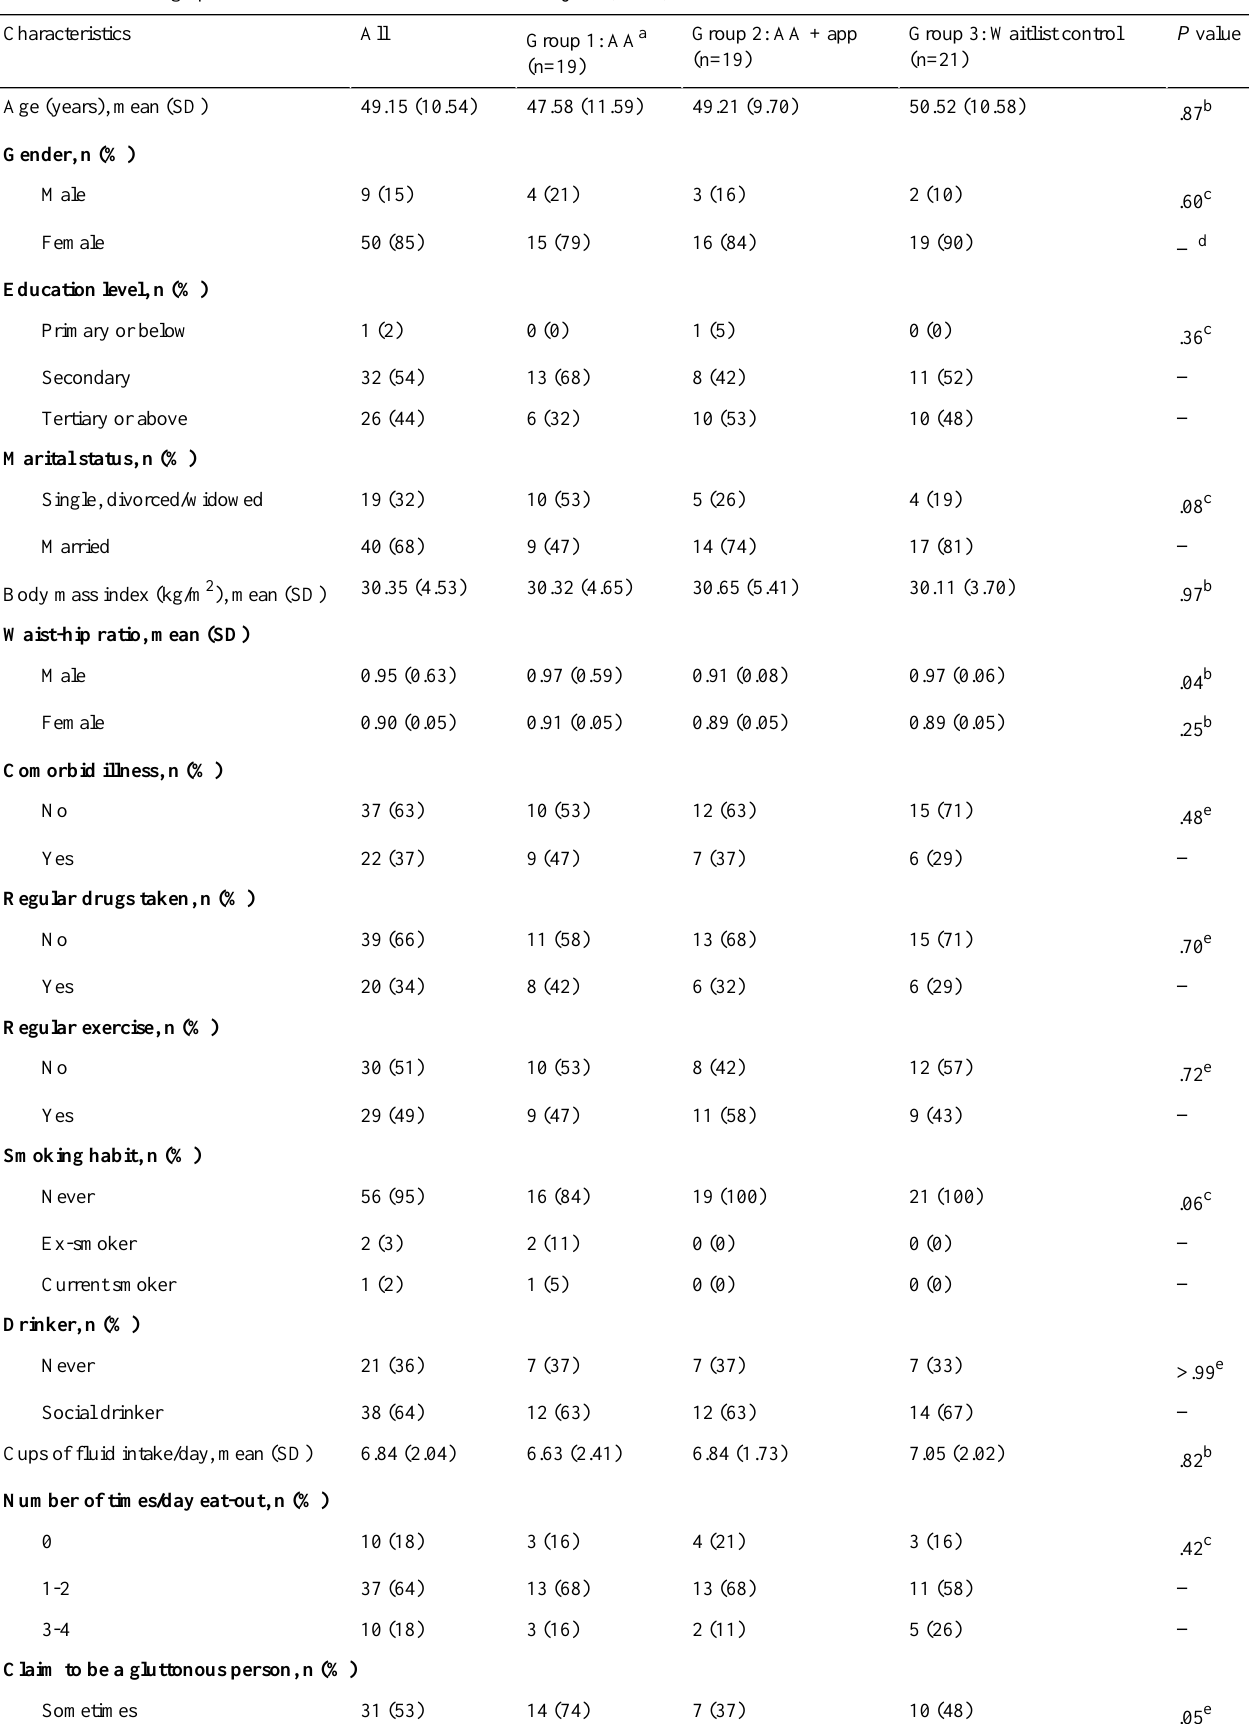
Table 1. Sociodemographic and baseline characteristics of the subjects